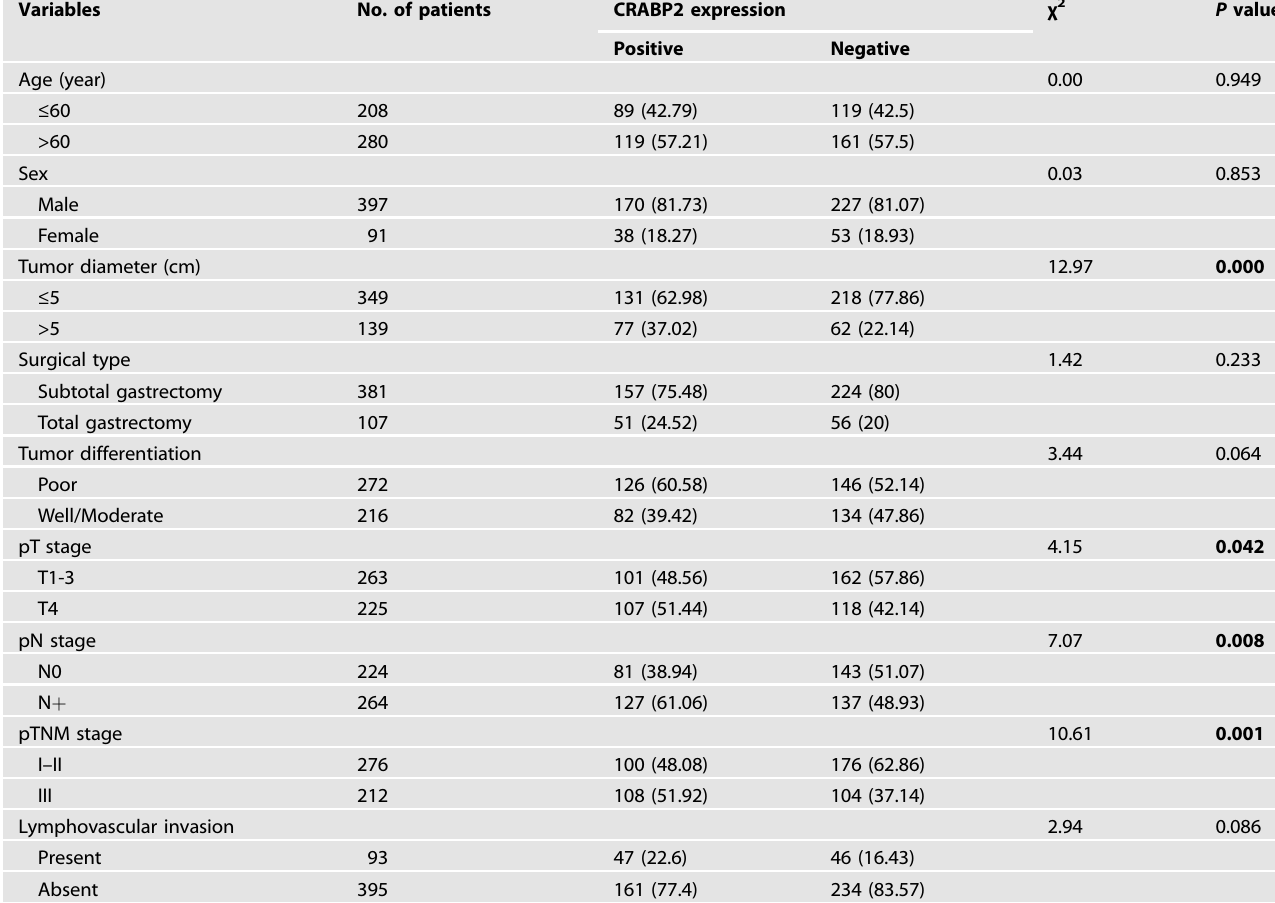
Table 1. Correlation between CRABP2 expression and the clinicopathological characteristics of GC